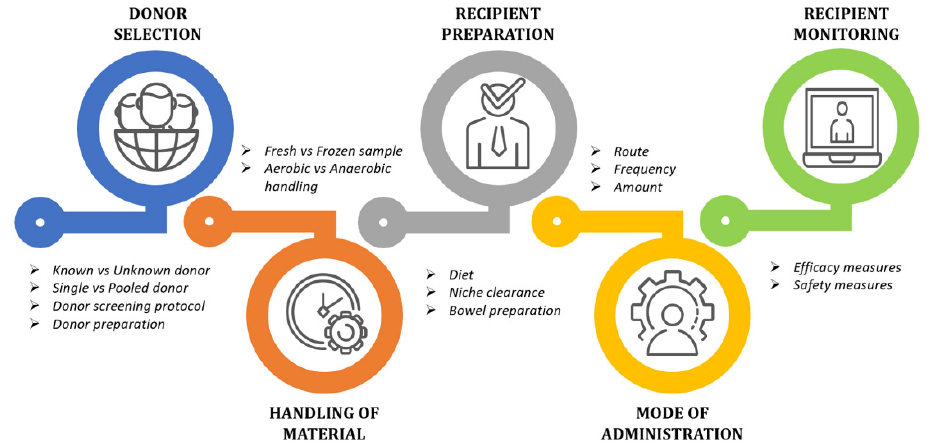
Figure 3. Challenges in Fecal Microbiota Transplantation (FMT) therapy.